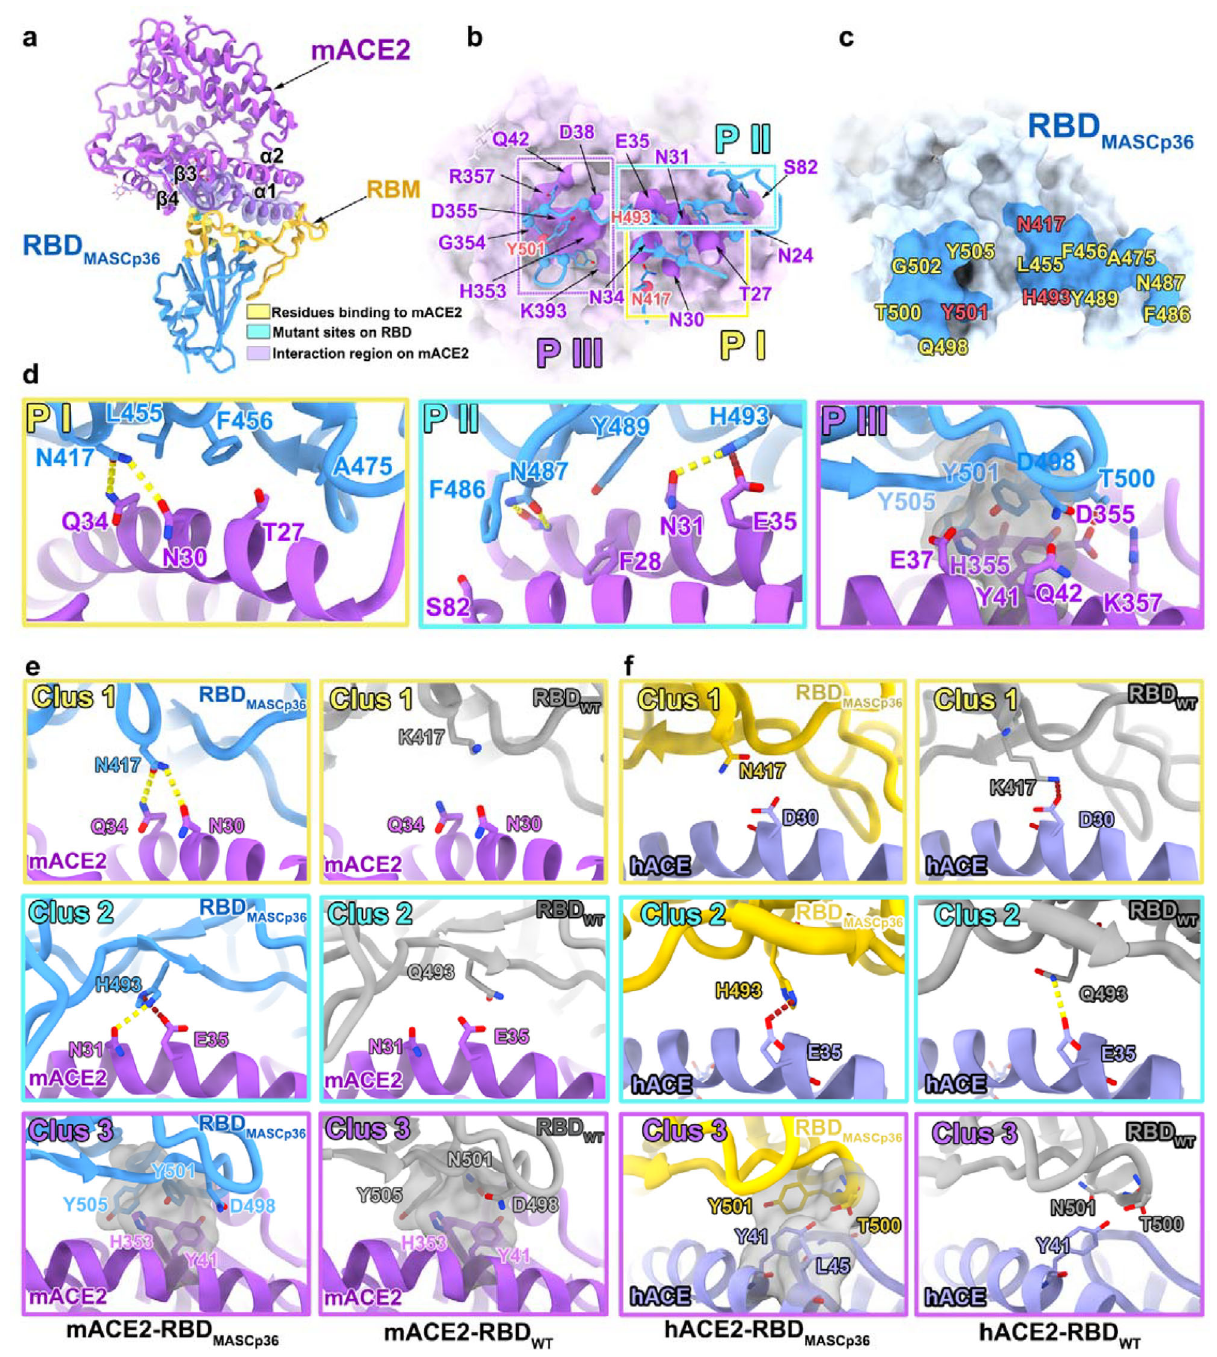
Fig. 10 Mechanism of binding of SARS-CoV-2-derived MASCp36 to mACE2. a Overall structure of RBD MASCp36 bound to mACE2. Residues of RBD MASCp36 participating in the binding to mACE2 are shown as spheres and colored in yellow, the mutation sites are colored in cyan, the RBM is colored in gold. The region of mACE2 responsible for binding is labeled. b , c The binding interface between RBD MASCp36 and mACE2. The residues involved in binding to mACE2 are presented as sticks, and the residues of mACE2 interacting with RBD MASCp36 are shown as surface. The mutated residues in RBD MASCp36 are colored in red. d Details of the interactions between RBD MASCp36 and mACE2. Some residues involved in the formation of hydrophobic patches (gray mesh), salt bridge (red dash), and hydrogen bonds (yellow dash) are shown as sticks and labeled. e The comparison of interactions at RBD WT -mACE2 and RBD MASCp36 -mACE2 interface. RBD WT , RBD MASCp36 , and mACE2 are colored in gray, cyan, and purple, respectively. The residues involved in the formation of hydrophobic patches (gray mesh), salt bridge (red dash), and hydrogen bonds (yellow dash) are shown as sticks and labeled. f The comparison of interactions at RBD WT -hACE2, RBD MASCp6 - hACE2, RBD MASCp25 -hACE2, and RBD MASCp36 -hACE2 interface. RBD WT , RBD MASCp6 , RBD MASCp25 , and RBD MASCp36 are colored in gray, red, yellow, and cyan,